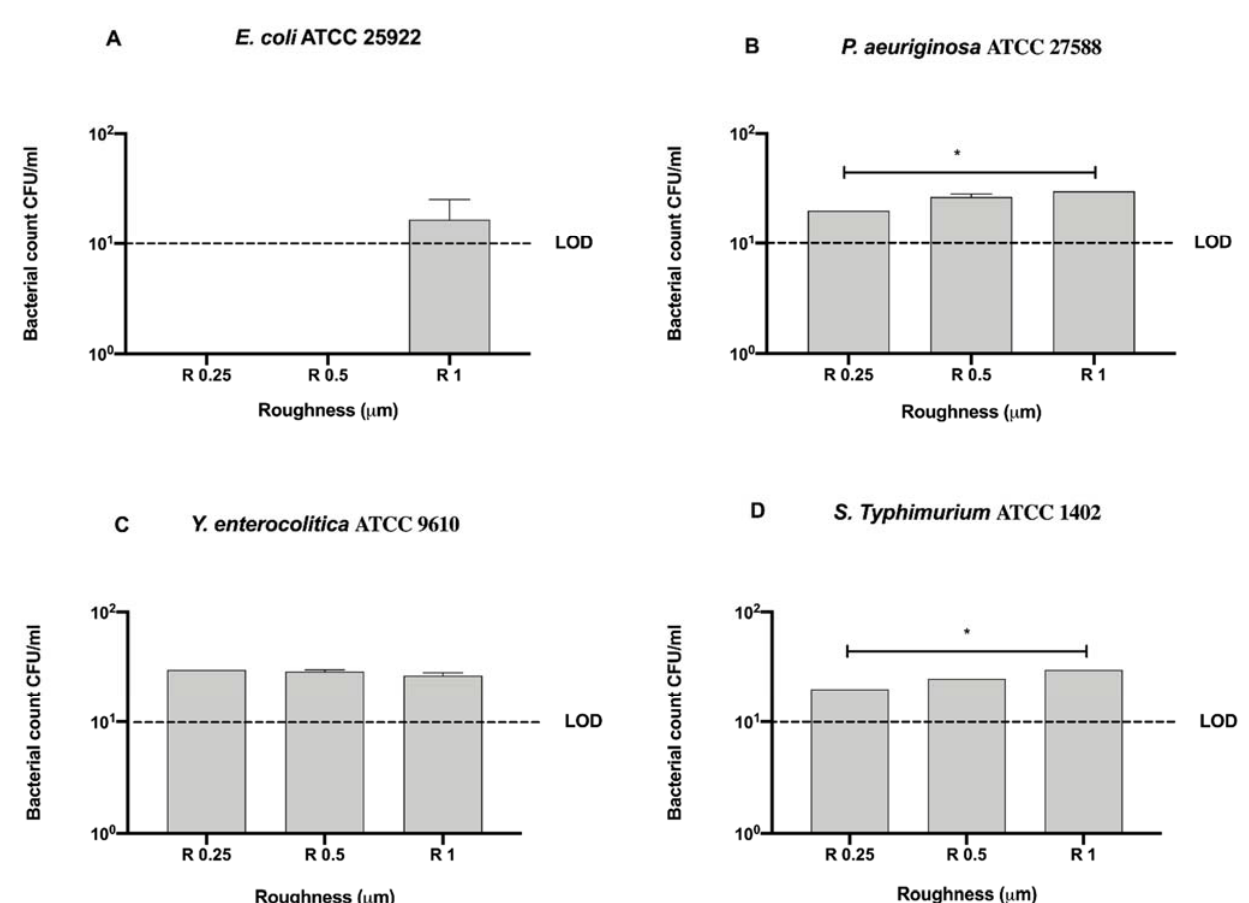
Figure 8. Graphical representation of the antibacterial activity of different AISI 316 stainless steel surface roughness coated with nanoXHAM ® D against Gram-negative bacteria ( A–D ), * p < 0.05; Limit of detection (LOD) is 10 1 (10E+1).